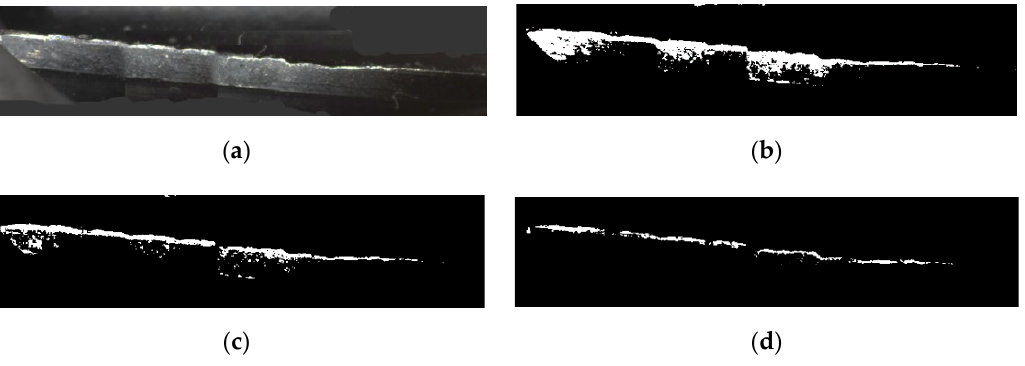
Figure 12. Segmentation results of three algorithms. ( a ) Stitched original image; ( b ) Otsu threshold adaptive segmentation algorithm; ( c ) K-means clustering algorithm; ( d ) FCN segmentation.